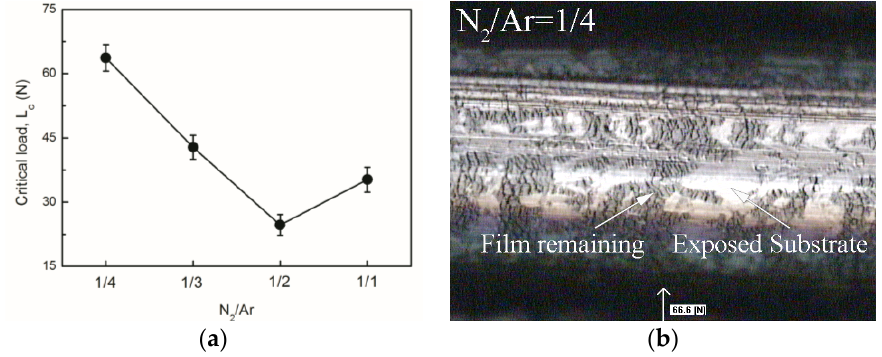
Figure 7. The critical load and the scratch morphology of the AlCrSiN coatings as a function of N 2 /Ar flow ratio: ( a ) Critical load of coatings; ( b ) Scratch morphology of coatings.